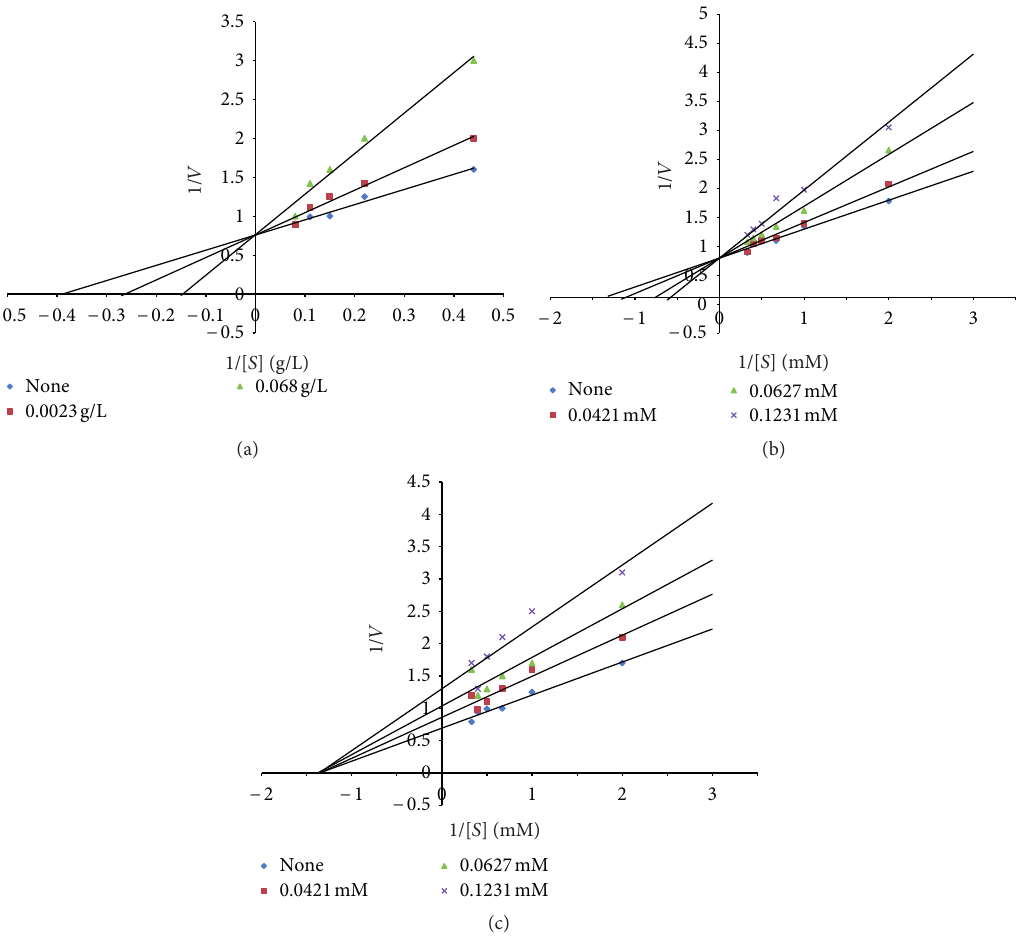
F 4: Inhibition studies on Cucumeropsis manii seed LOX. (a) shows a competitive inhibition with the crude extract. (b) shows a competitive inhibition with ascorbic acid. (c) Noncompetitive inhibition with propyl